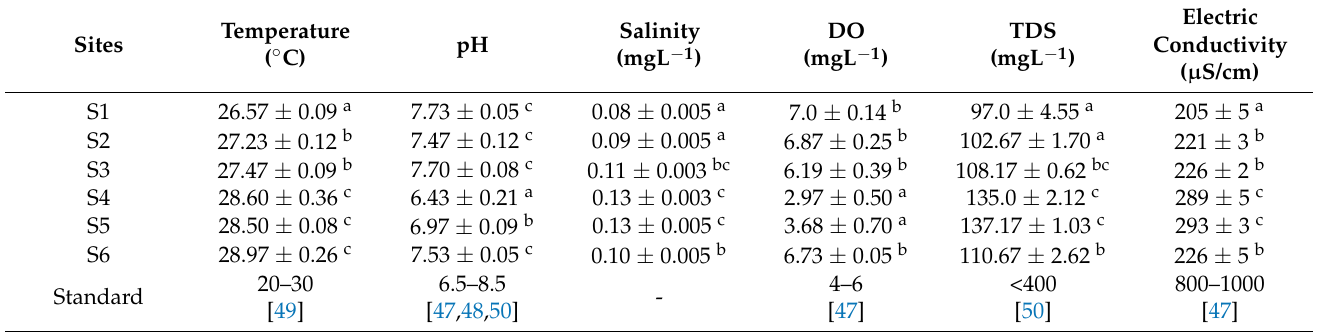
Table 3. Physicochemical properties of water at different sampling locations with standard values (values are mean ± standard error; the column with different superscripts indicates significant differences at p < 0.05